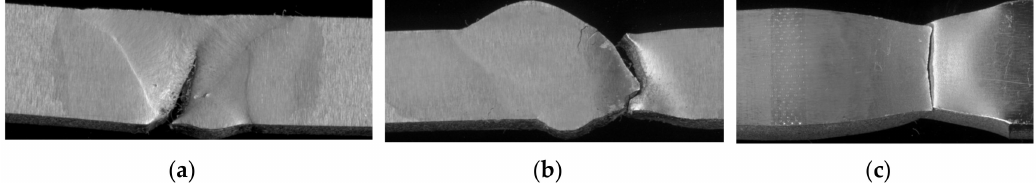
Figure 16. Views of broken welded joints made according to the regimes: ( a ) Q 1 in WM; ( b ) Q 3 in HAZ; ( c ) Q 5 in